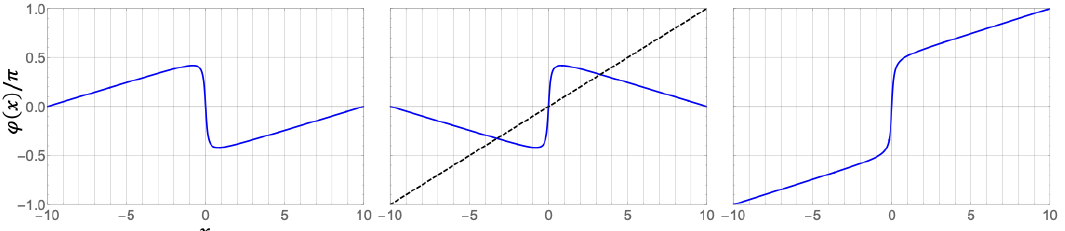
Figure 16. Phase profile arg [ ψ g ( x )] / π (red curve) for N = L = 20 and c = 0.1 divided by the vertical line x = 0 (blue line).